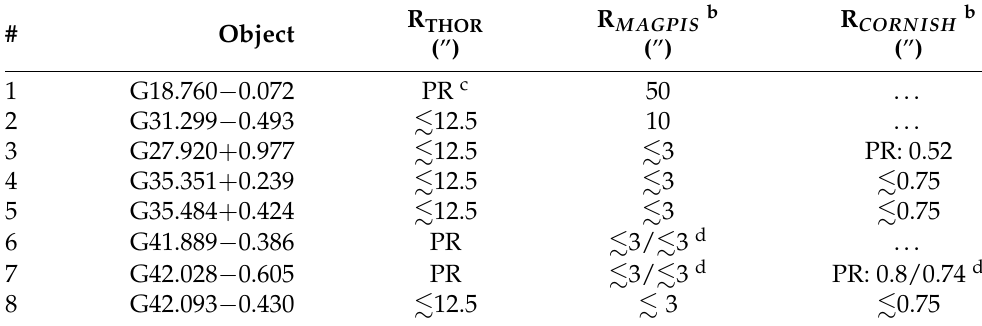
Table 3. Angular radii of the galactic non-thermal sources a